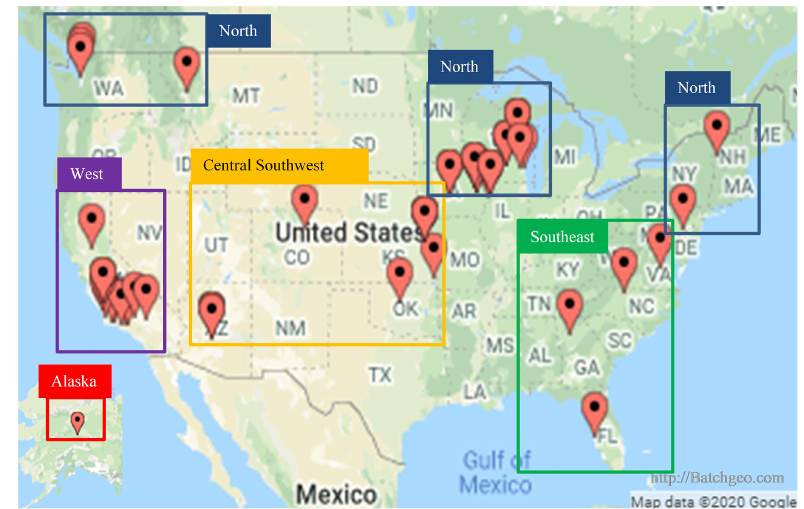
Figure 2. State, local, and tribal (SLT) air monitoring sites with collocated PurpleAir sensors, including regions used for correction model evaluation. Table 1. Summary of the dataset used to generate the US-wide PurpleAir correction equation after three sensors with large A–B channel discrepancies were removed. PM 2 . 5 concentrations from both the FEM or FRM and the raw PurpleAir (PA), temperature ( T ) and relative humidity (RH), are summarized as median (min,